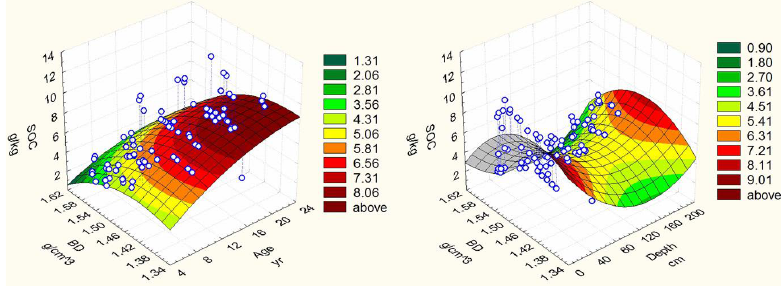
Figure 5. Regression models of soil organic carbon (SOC) and bulk density (BD) with extension of stand age and soil depth.